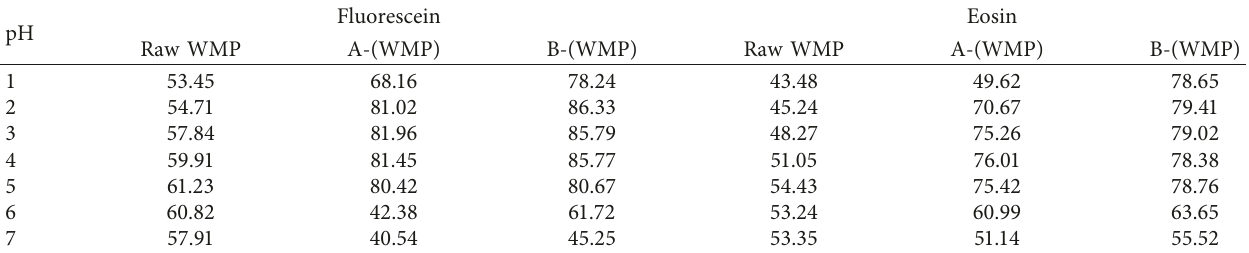
Table 6: Effect of pH on sorption efficiency of the sorbent (WMP).